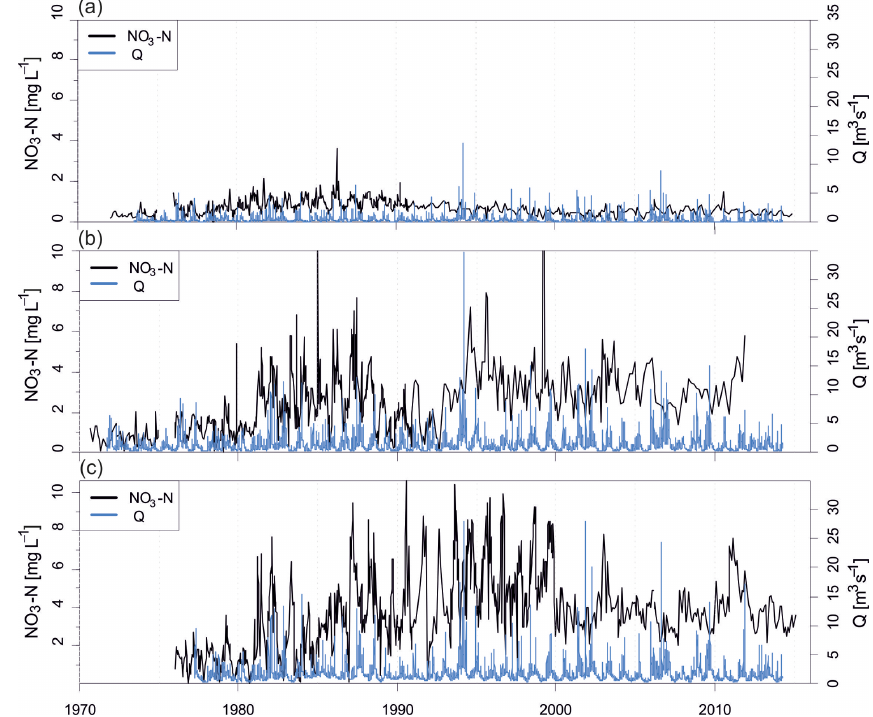
Figure 2. NO 3 –N concentration and discharge ( Q ) time series: upstream (a) , midstream (b) and downstream (c)